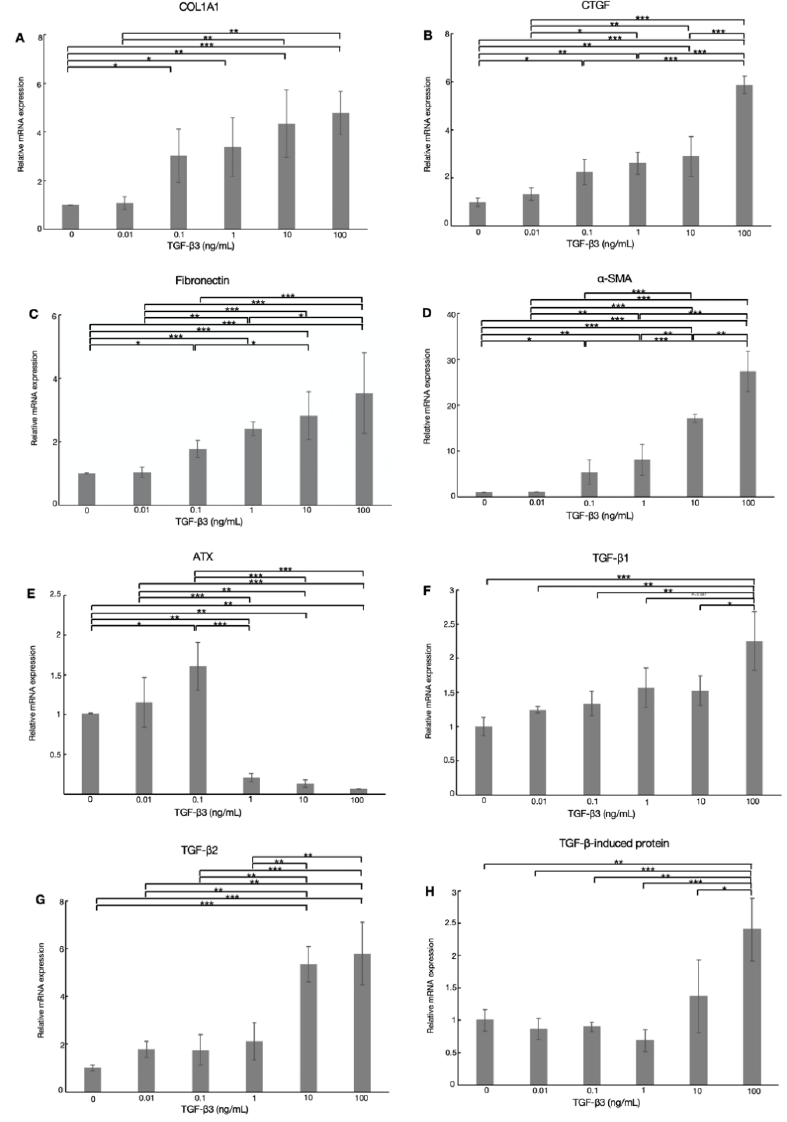
Figure 2. Real-time qPCR analysis of the mRNA levels of ( A ) COL1A1, ( B ) CTGF, ( C ) fibronectin, ( D ) α -SMA, ( E ) ATX, ( F ) TGF- β 1, ( G ) TGF- β 2, and ( H ) TGF- β -induced protein after stimulation with different concentrations (0, 0.01, 0.1, 1, 10, 100 ng/mL) of TGF- β 3 in HTM cells. The mRNA expression levels of COL1A1, CTGF, fibronectin, α -SMA, TGF- β 1, TGF- β 2, and TGF- β -induced protein were significantly increased after treatment with TGF- β 3. The ATX mRNA level was significantly increased with 0.1 ng/mL TGF- β 3 treatment and significantly decreased with >1 ng/mL TGF- β 3. GAPDH was used as an internal control for normalization. Data are presented as the mean ± standard deviation. * p < 0.05, ** p < 0.01, *** p < 0.001, n =